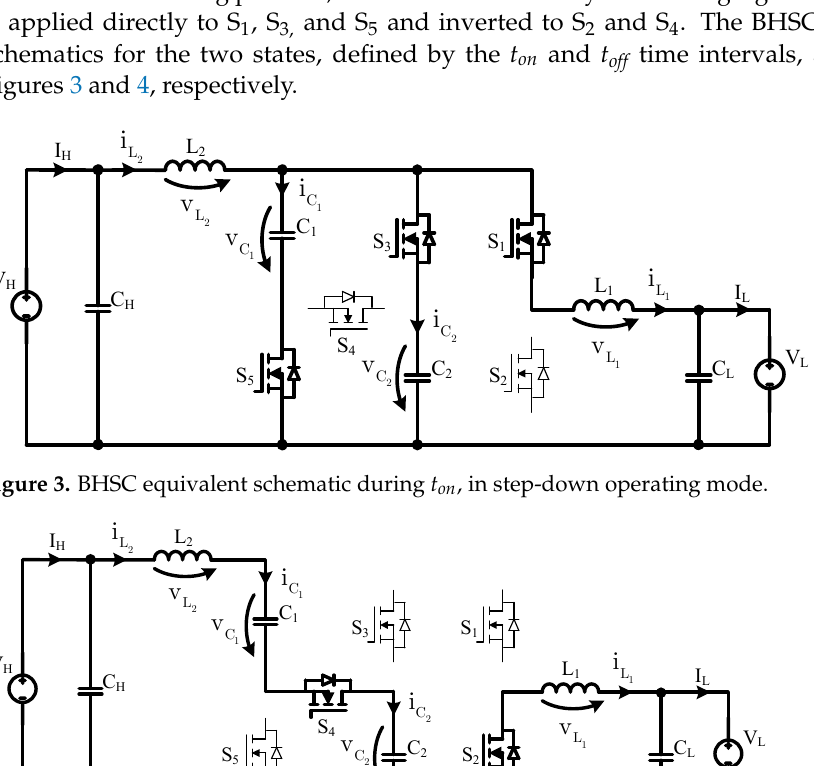
off , in step-down operating